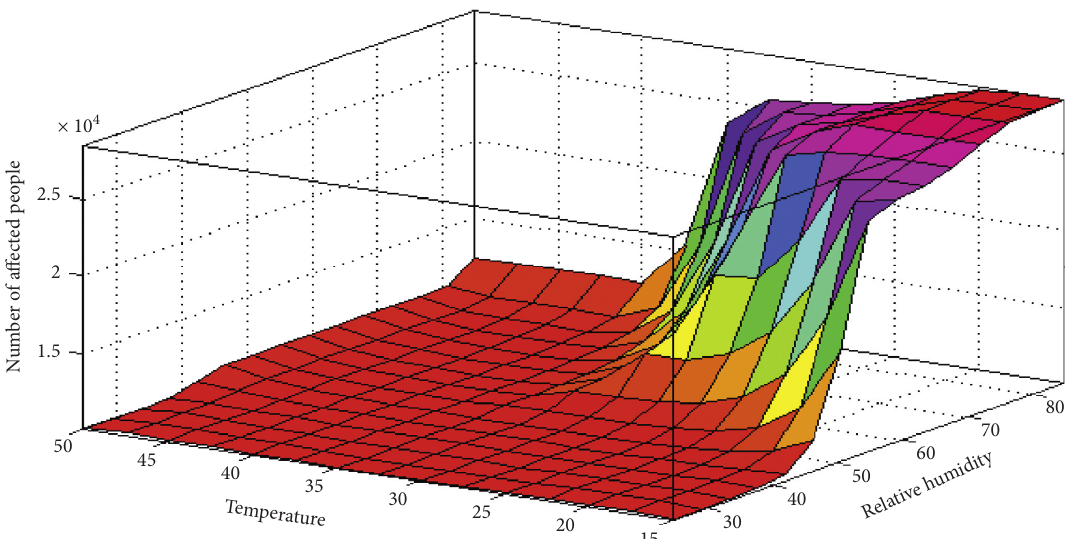
Figure 4: Relationship between temperature, RH, and the number of affected